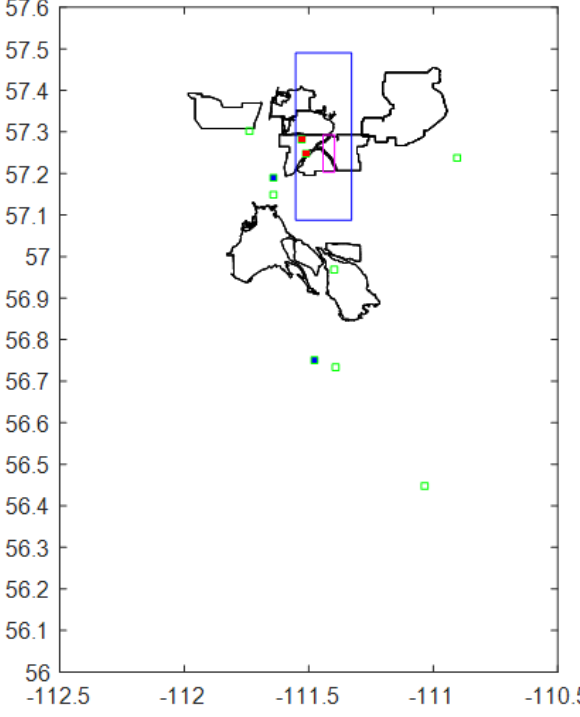
Figure 4. Areas with a significant positive trend in AOD in the POLDER/PARASOL and MODIS Aqua DB data records. The area over which the AOD time series is determined for MODIS Aqua DB (0 . 1 × 0 . 1 ◦ ) and POLDER/PARASOL (0 . 4 × 0 . 4 ◦ ) is outlined in pink and blue, respectively. Locations of 10 NAPS PM 2 . 5 moni- toring sites are also shown as small green squares. The central one of three adjacent (overlapping) grid cells at constant latitude is plot- ted for POLDER/PARASOL (see Sect. 3 for details). The grid cell with the largest trend in the domain is plotted for MODIS Aqua DB (see Sect. 3 for details). Note that the Albian mine site (57.2808 ◦ N, 111.526 ◦ W) was replaced by the nearby Shell Muskeg River site (57.2491 ◦ N, 111.509 ◦ W) in 2009 (both station symbols are filled in red). The two AERONET instruments are co-located with NAPS monitors, and the markers for those sites are filled in blue.